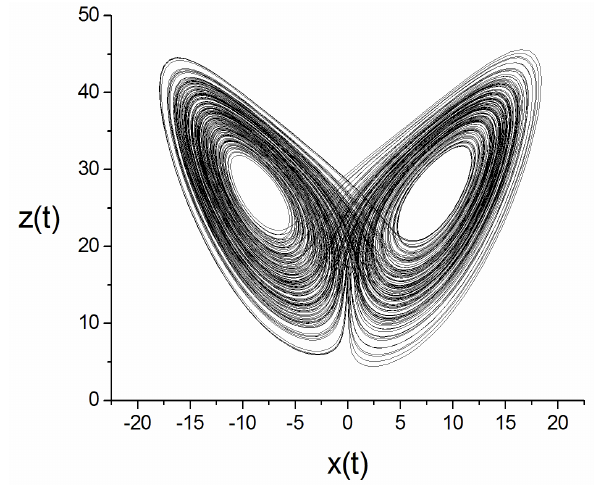
Figure 13: The Lorenz butterfly attractor, namely the time behavior of the variables 𝑧 ( 𝑡 ) vs. 𝑥 ( 𝑡 ) as ob- tained from the Lorenz’s model (see Equation (22)). This figure has been obtained by using the parameters 𝑃 r = 10, 𝑏 = 8 / 3, and 𝑅 =